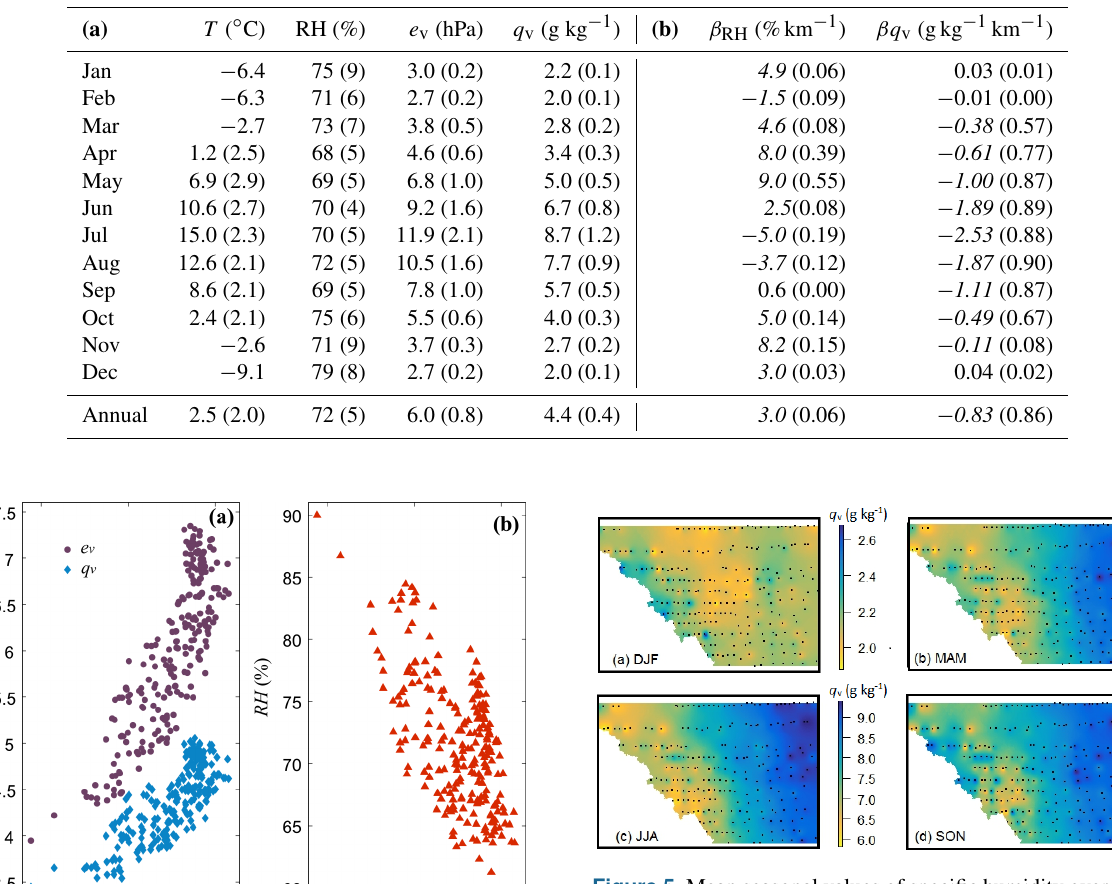
Figure 5. Mean seasonal values of specific humidity over the study region (gkg − 1 ): (a) winter (DJF), (b) spring (MAM), (c) summer (JJA), and (d) autumn